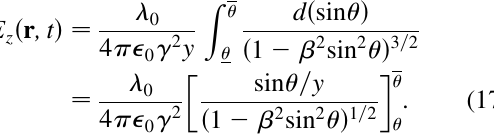
FIG. 1. Definition of coordinates. Snapshot of moving string (the open rectangle) at the ‘‘present’’ time t (cid:1) 0 . The solid line indicates the electrostatic configuration temporarily equivalent to the ‘‘true’’ electrodynamic system of a moving charged string; there are charges in just those locations that, at some time t < 0 , contribute to the electric field at test point P at t (cid:1) 0 . In this figure that point is labeled P and is instantaneously located at z (cid:1) 0 (cid:3) (cid:8) (cid:6)ct z 0 (cid:1) (cid:2) L (cid:4) z ; t r